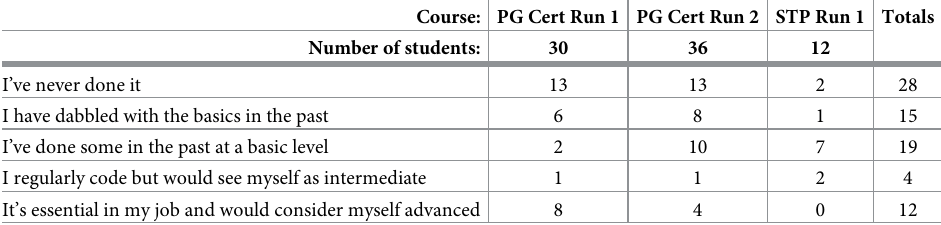
Table 2. Results of poll investigating experience of